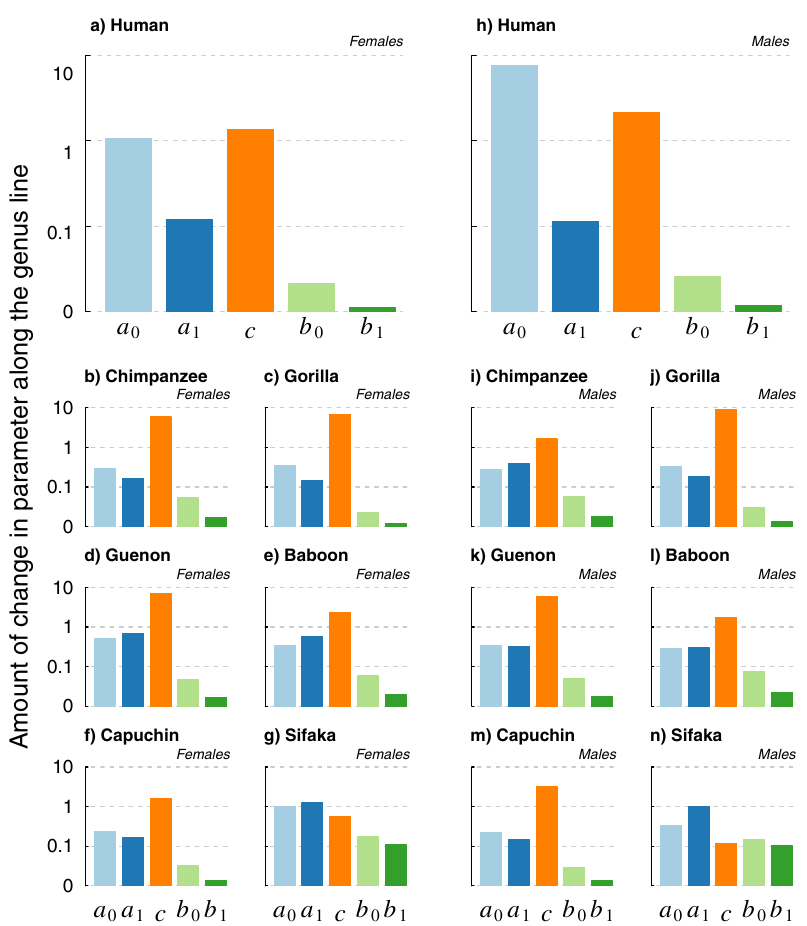
Fig. 3 Relative magnitude of change of each parameter along the genus lines. Pre-adult and age-independent mortality parameters ( a 0 a 1 , and c ) vary several orders of magnitude more, within each genus, than the ageing parameters ( b 0 and b 1 ). Colours: a 0 (light blue) a 1 , (dark blue), c (orange), b 0 (light green) and b 1 (dark green). Values were calculated by numerically solving the path integral in Eq. (9) (see ‘ Material and Methods ’ ) for each parameter along each genus line. The y -axes were scaled by the logarithm base 10 to improve interpretability. a – g depict results for females, and h – n for males (Source data are provided as a Source Data File and available in Supplementary Table